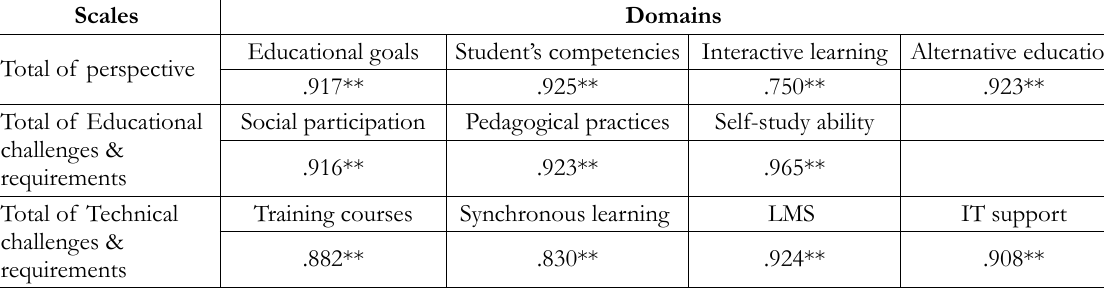
Table 7. Correlations between domains and